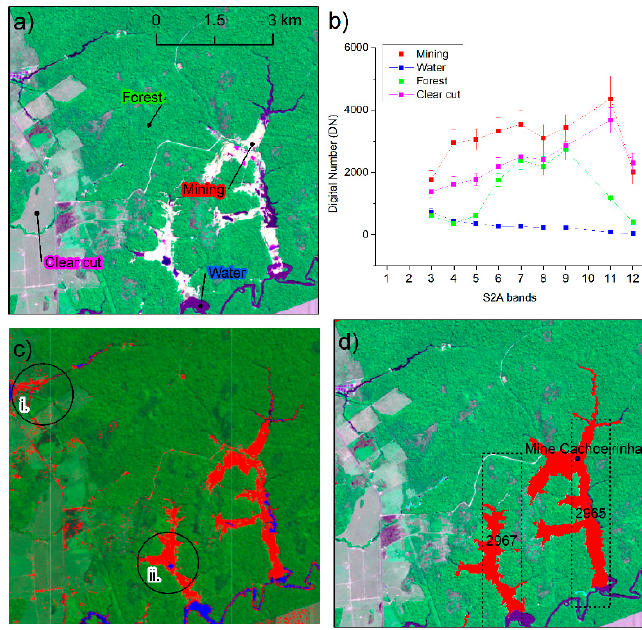
Figure 3. Illustration of the classification process for an industrial mining in Itapuã do Oeste/RO: ( a ) Sample selection for four classes used (Mining in red, water in blue, forest in green and clear-cut areas in magenta). ( b ) Average and standard deviation of Sentinel-2A spectra for 25 pixels of each class, ( c ) Classification result from GEE based on CART (Classification and Regression Trees), only mining areas in red and water areas in blue are shown: (i) indicates commission areas within mining class; and (ii) indicates water bodies derived from mining activities and, therefore, integrated into mining class. ( d ) Final mining area map after vector edition with indication of Mining License Areas (dashed rectangles) used for type of ore identification (see Table 2 for details on Mining License). Table 2. Example of information related to the Exploitation License given by DNPM (National Department for Mineral Production). Process numbers refer to the areas indicated in Figure 3d. In this case, two industrial companied have the license to exploit tin in Itapuã do Oeste (RO) with 485 ha each.